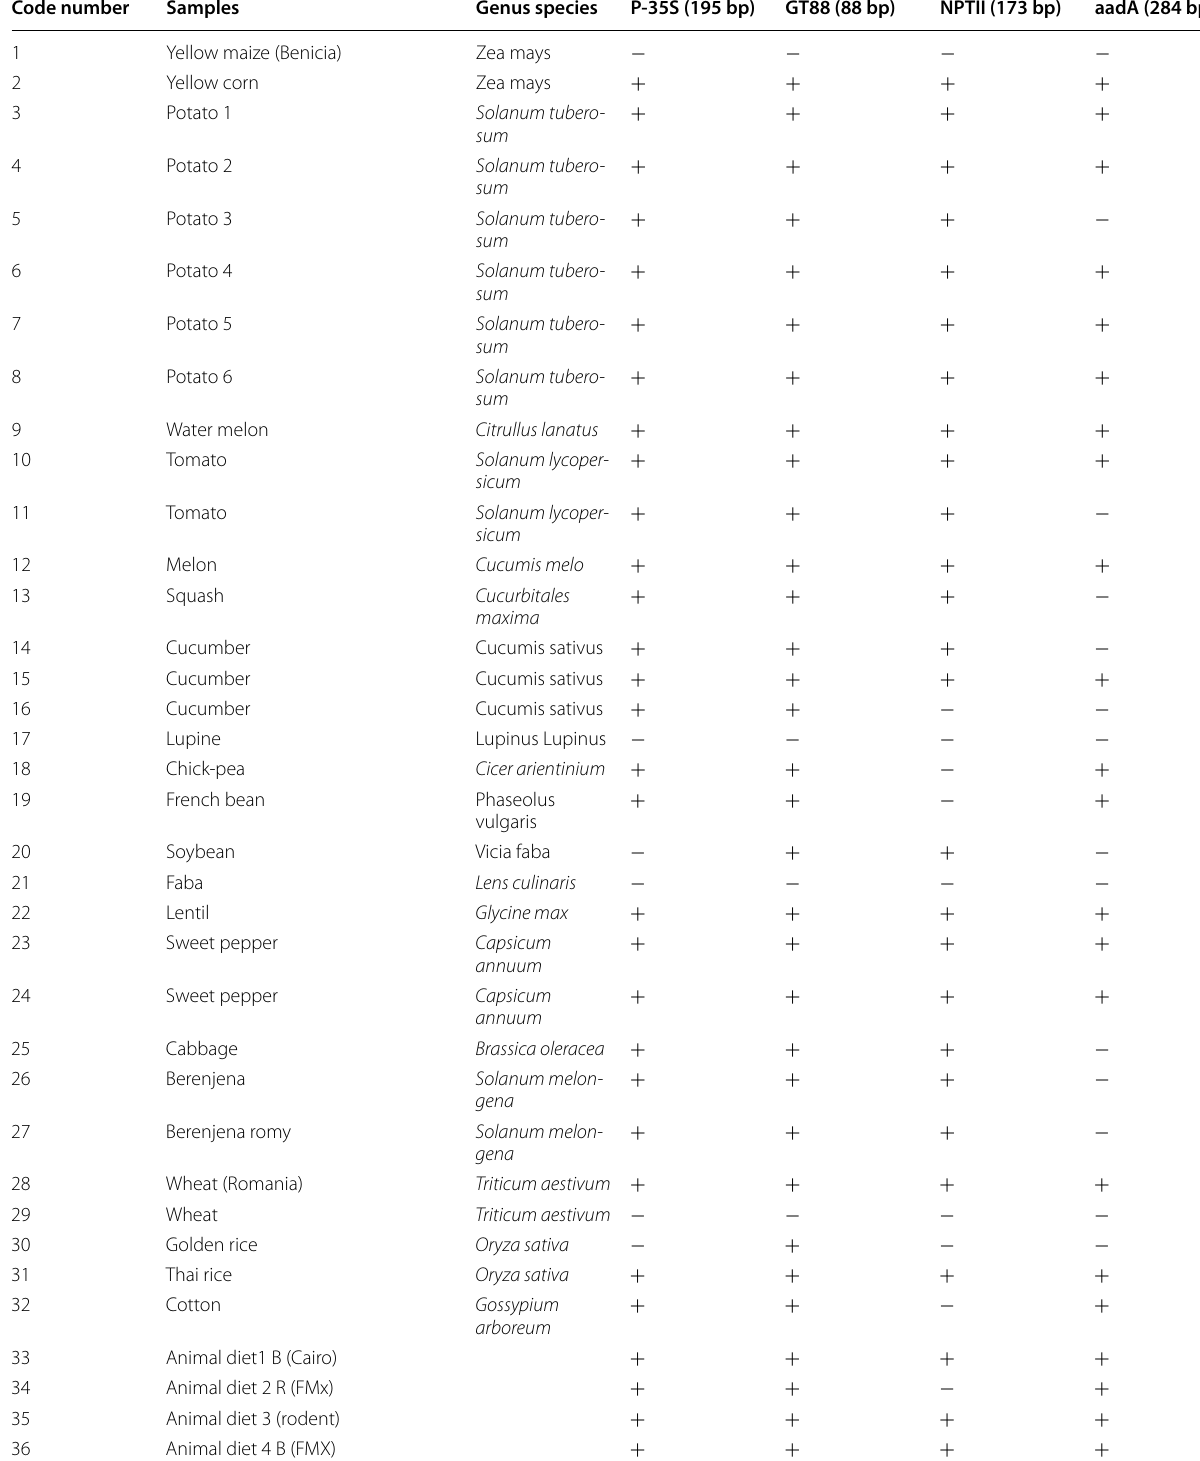
Table 2 Detected genetic modifications in some of the collected plant samples using primers for P – 35S (195 bp), GT 88 (88 bp) , nptII (173 bp) and aadA1 (284